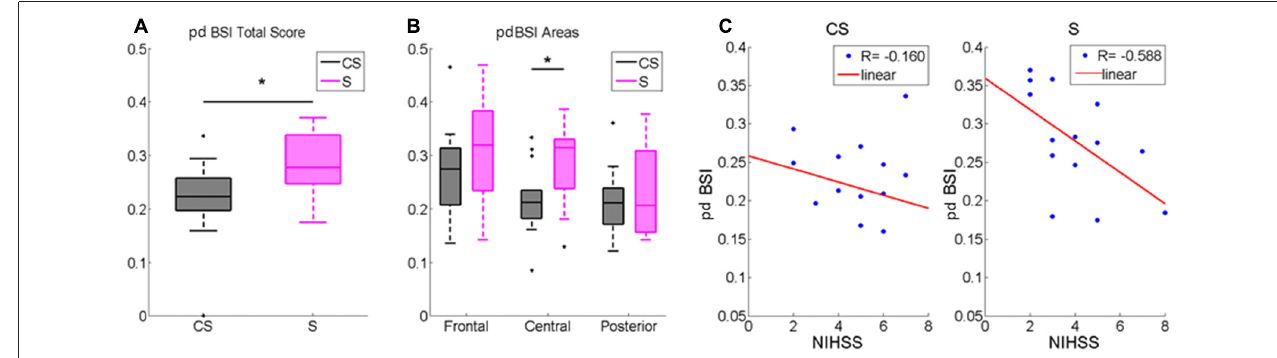
FIGURE 4 | Pairwise derived brain symmetry index (pdBSI) computed for (A) the whole scalp and for (B) Frontal, Central and Posterior Areas. Median and IQR of pdBSI in Cortico-subcortical lesioned patients (CS) and Subcortical lesioned patients (S). ∗ p < 0.05. (C) pdBSI and NIHSS score correlation in Cortico-subcortical lesion group (CS) and in Subcortical lesion group